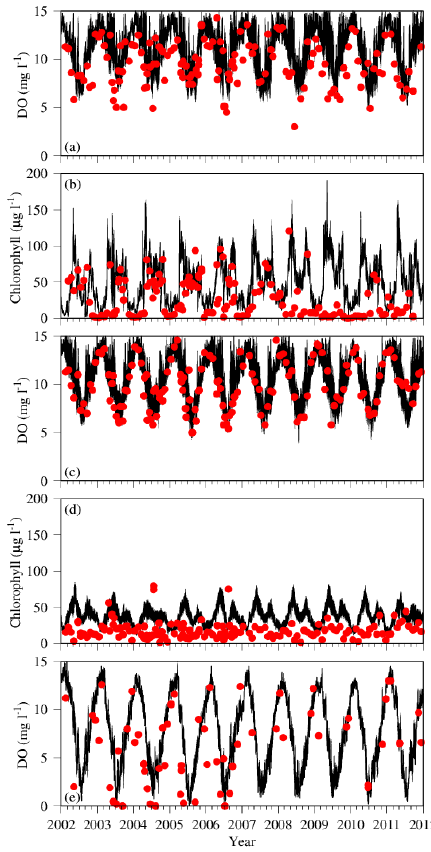
Figure 3. Time series of observation (red dots) and simulation (black lines) of DO and chlorophyll at the long-term monitoring stations ET4.1 in the tidal-fresh zone ( a , b ) and ET4.2 in the mesohaline region ( c – e ). Only the surface layer is depicted at the shallow Station ET4.1 and bottom DO ( e ) is added to the ET4.2 station in the deep mesohaline